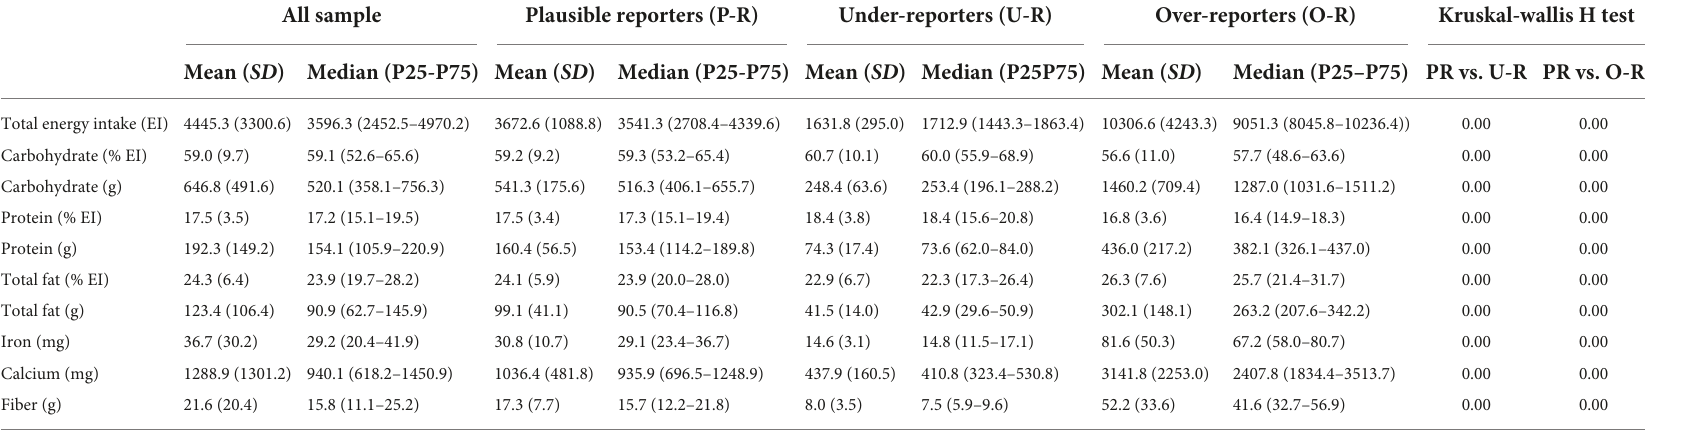
TABLE 2 Total energy intake and nutrient intake by misreporting status.